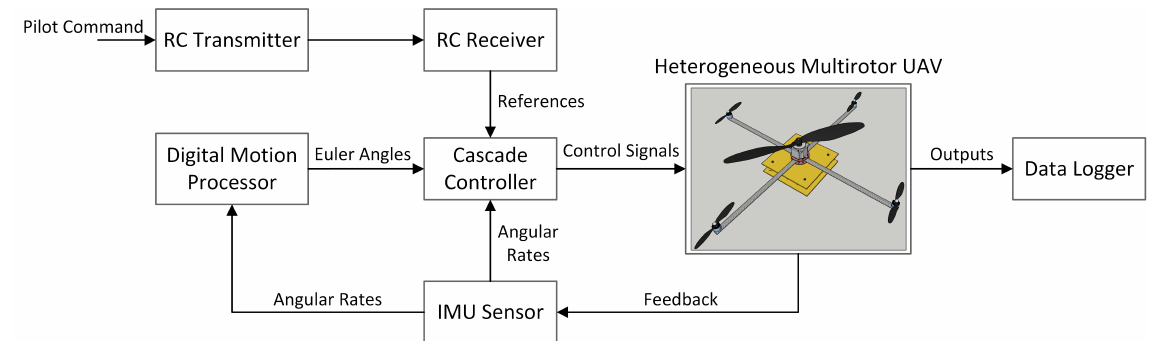
Figure 6. Flight control